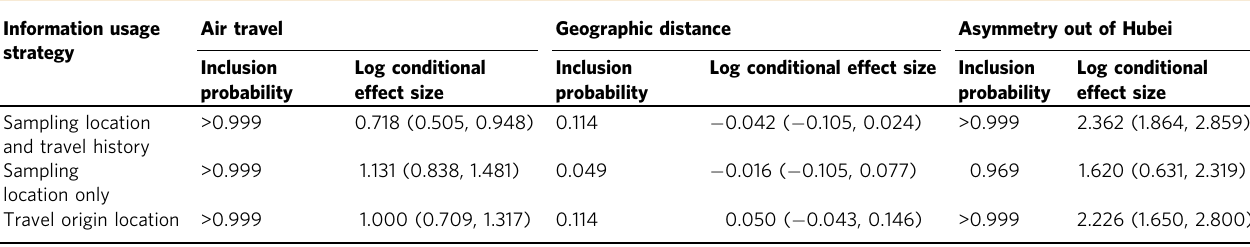
Table 1 Inferred generalized linear model (GLM) of discrete location transitions under three different usage strategies of travel history